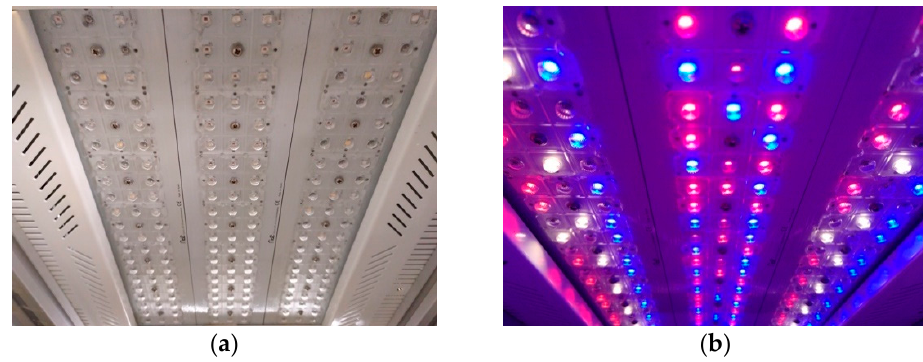
Figure 3. Illumination subsystem composed of LED arrays of different wavelengths: ( a ) OFF, ( b ) ON